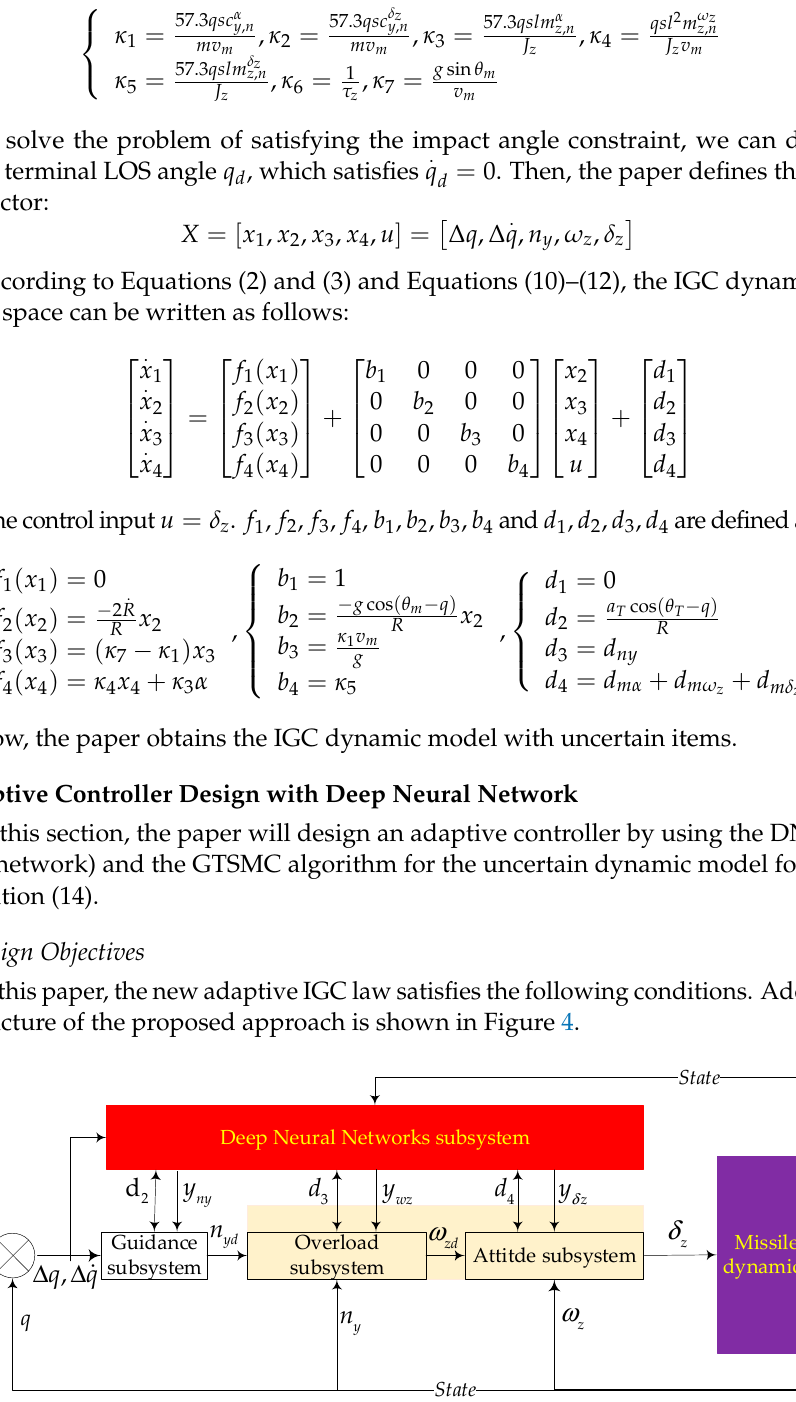
Figure 4. Structure of proposed